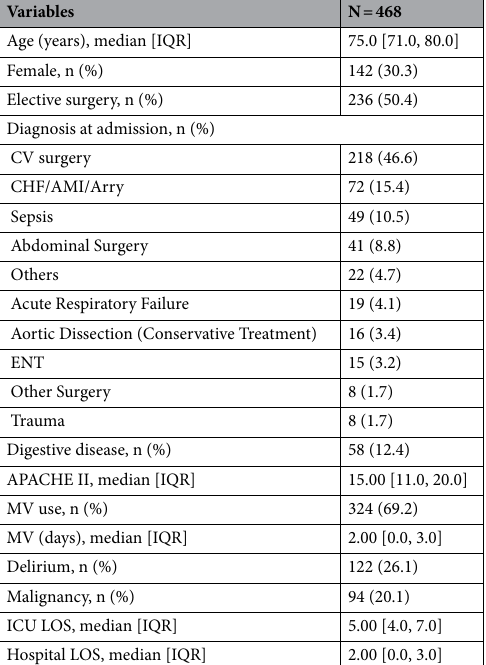
Variables Without poor appetite, n = 349 With poor appetite, n = 119 P